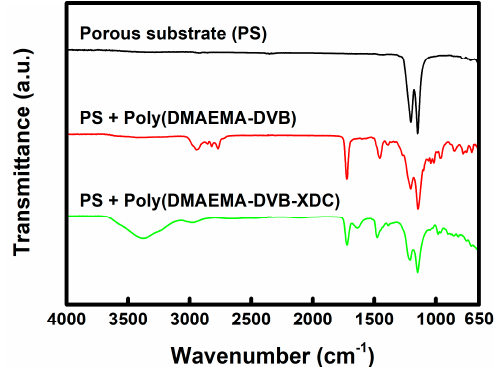
Figure 2. FT-IR spectra of porous PTFE substrate and pore-filled membranes.